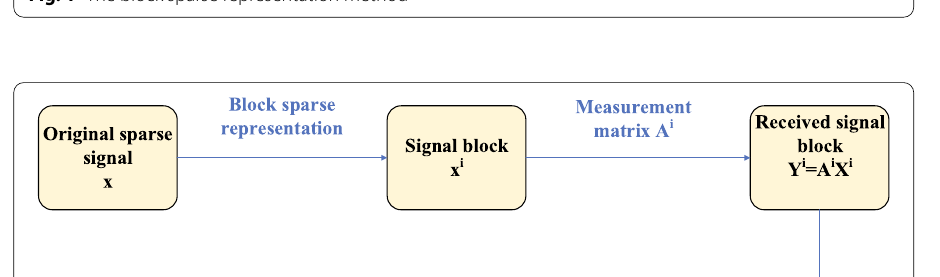
Fig. 1 The block sparse representation method